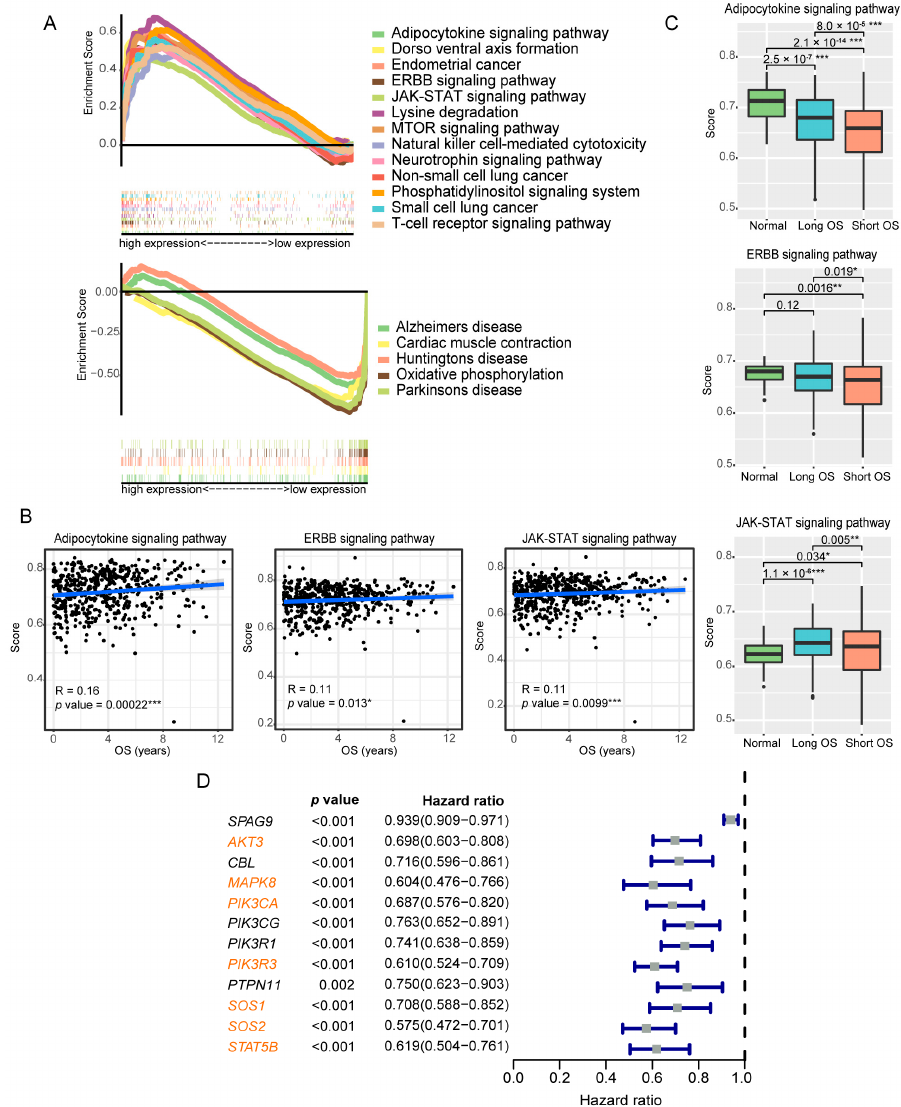
Figure 5. Analysis of the stroma-rich group and key-gene screening. ( A ) Tissues from the stroma-rich group were divided into two groups based on the median SPAG9 expression (the high- SPAG9 - expression group and the low- SPAG9 -expression group), and GSEA analysis (in KEGG collection) was conducted, respectively. Each line represents one particular pathway with a unique color. At the bo tt om, genes up-regulated in a particular pathway are on the left of x-axis; by contrast, the down-regulated genes are on the right. Only pathways with |NES| > 2 and FDR p values ≤ 0.05 are shown. Top: the enriched pathways in the high- SPAG9 -expression group; bo tt om: the enriched pathways in the low- SPAG9 -expression group. ( B ) Sca tt er plots showing the correlation between the activity scores of the adipocytokine-signaling pathway ( left ), ERBB-signaling pathway (middle), and JAK-STAT-signaling pathway ( right ) and OS in ccRCC. ( C ) The activity scores of the adipocyto- kine-signaling pathway ( up ), ERBB-signaling pathway ( middle ), and JAK-STAT-signaling pathway ( down ) in tissues with di ff erent levels of malignancy. Normal: ccRCC paracancerous tissues; Long OS: ccRCC tissues from patients with longer OS (OS > median OS); Short OS: ccRCC tissues from patients with shorter OS (OS < median OS). ( D ) Univariate Cox analysis of the expression of SPAG9 and candidate genes in ccRCC. The selected key genes are marked in orange. * p value < 0.05, ** p value < 0.01, *** p value < 0.001